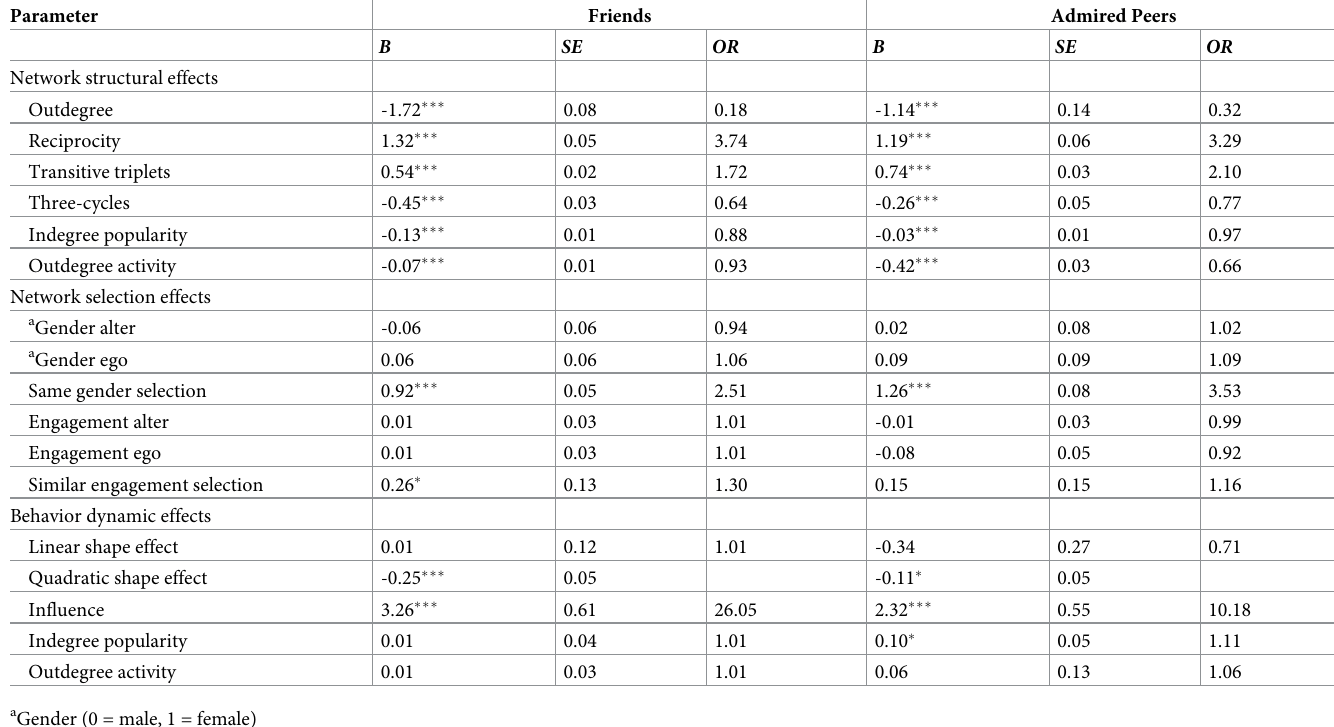
Table 3. SAOM results in the social networks of friends and admired peers.